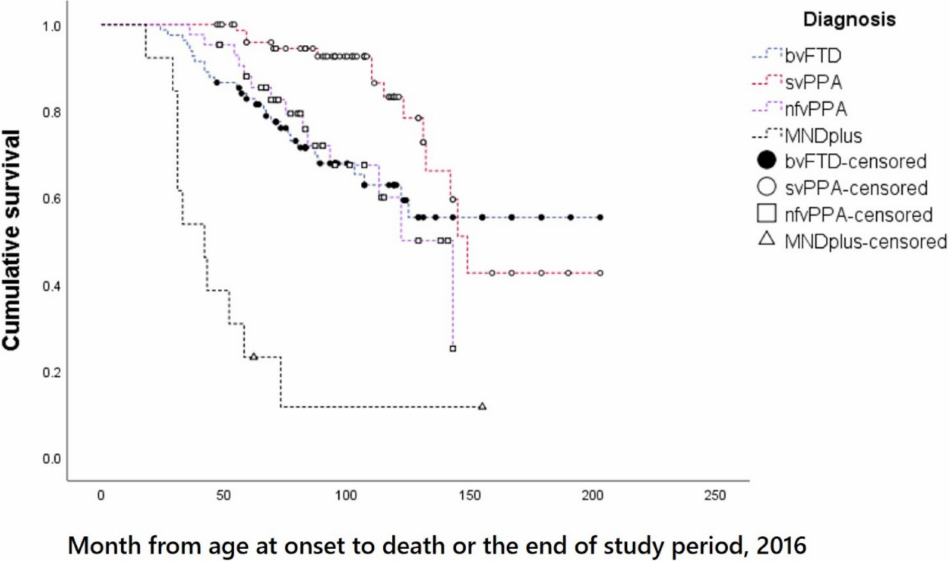
Figure 1. Kaplan-Meier survival plots for the 4 subtypes of FTD. Abbreviations: bvFTD, behavioral variant frontotemporal dementia; FTD-MND, frontotemporal dementia with motor neuron disease; nfvPPA, non-fluent/agrammatic variant primary progressive aphasia; svPPA, semantic variant primary progressive